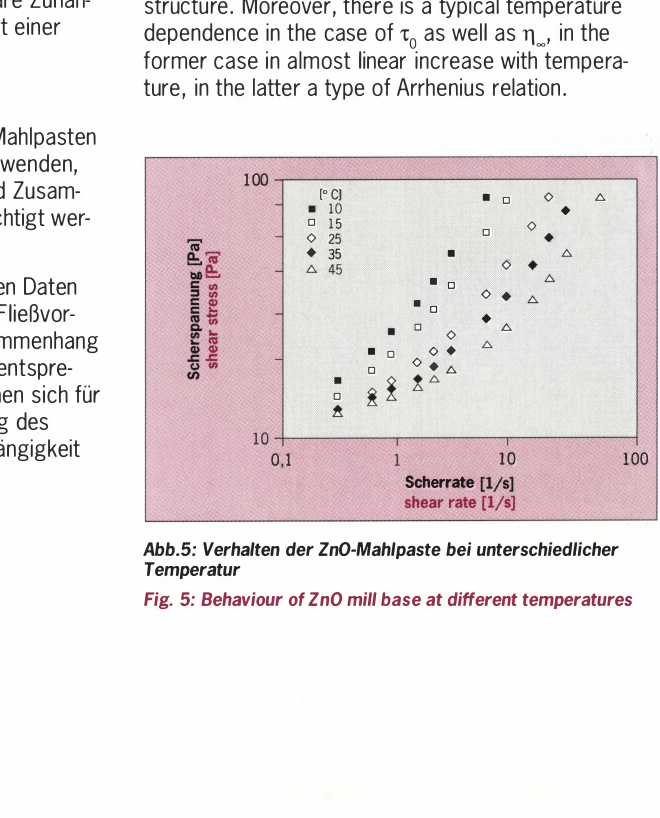
Tabelle 2: Zusammenhang zwischen FlieBgrenze und Vermahlungsgrad bei zuneh­ mender Vermahlungsdauer fur Mahlpaste .B" (Laboran­ satz} Table 2: Relation between yield point and degree of grinding with increasing grinding time, for mill base .B" (laboratory batch}